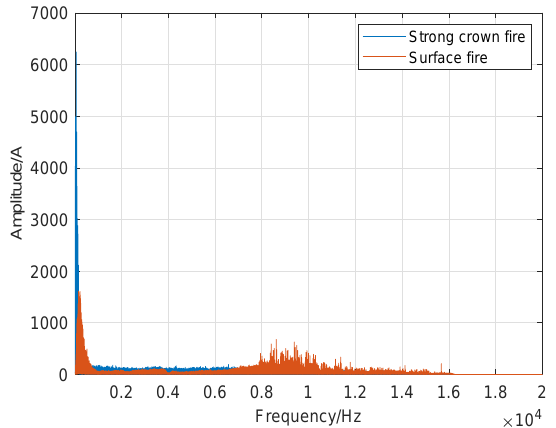
Figure 21. Comparison of strong crown fire and surface fire.